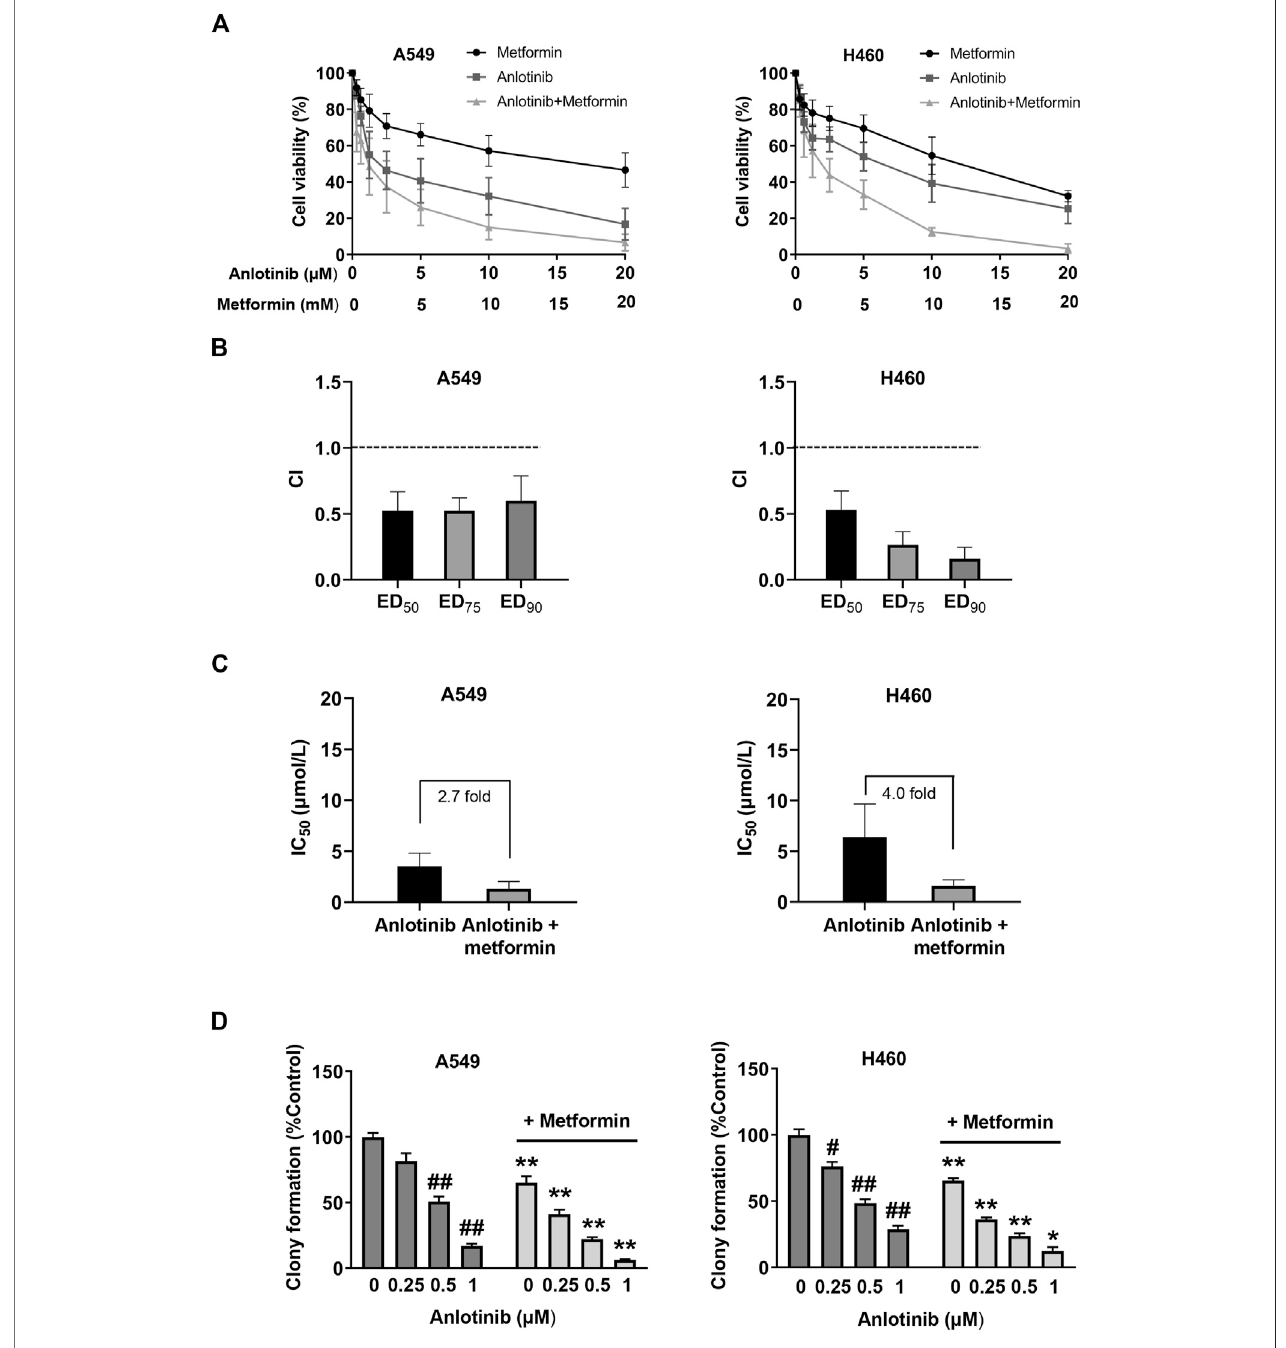
FIGURE1| Metforminenhancesthecytotoxicityofanlotinibinnon-smallcelllungcancer(NSCLC)cells (A) A549andH460NSCLCcellsweretreatedwithanlotinib (range, 0 – 20 μ mol/L), metformin (range, 0 – 20 mmol/L), or both for 3 days. Cell viability (%) was determined using the MTT assay (B) The CI values were determined for effective dose (ED) ED 50 , ED 75 , and ED 90 . Columns represent data from triplicate analyses ± SE (C) The IC 50 of anlotinib in A549 and H460 cells was reduced by the addition of metformin (D) A549 and H460 cells were exposed to the indicated concentrations of anlotinib alone or anlotinib combined with metformin (0.5 mM) for 48 h. Colony-forming ef fi ciency was determined 10 – 14 days later. Data are presented as means ± SE from three independent experiments. Statistical signi fi cance was analyzed using unpaired Student ’ s t -test; * p < 0.05, ** p < 0.01 compared with anlotinib alone; # p < 0.05, ## p < 0.01 compared with the untreated control group.